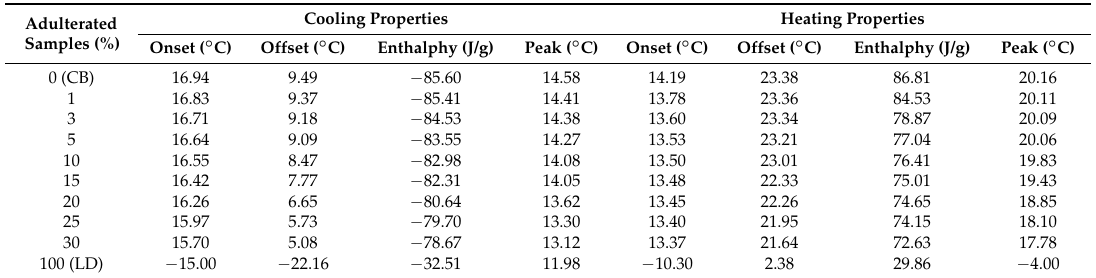
Table 4. Cooling and heating thermograms of cocoa butter, lard, and their admixtures. Adulterated Samples